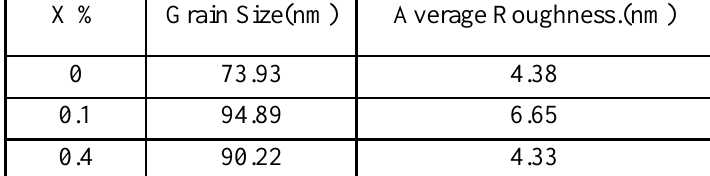
Fig. 2: AFM graphs of (Mg Table 3: Average grain size and average roughness obtained from AFM measurements for (Mg Si Al O ) where x= 0, 0.1, 1-x x 2 4